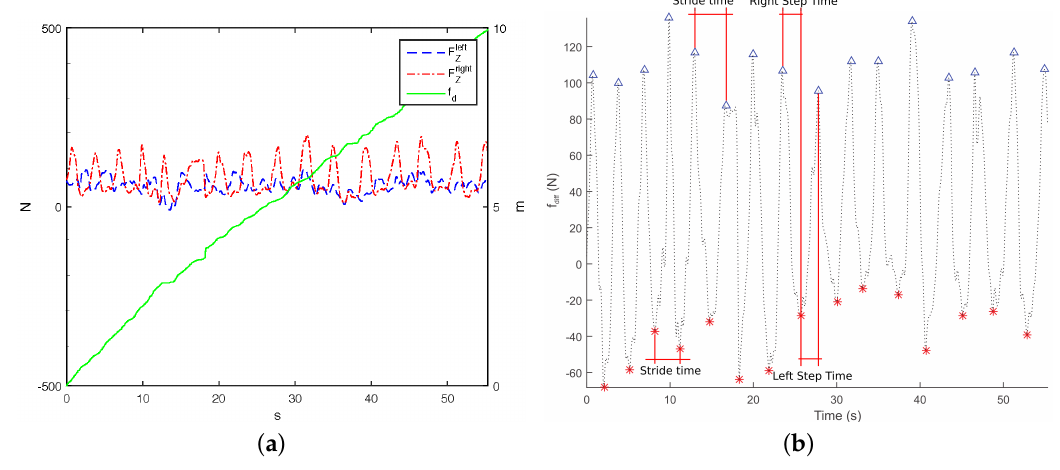
Figure 4. Spatiotemporal gait parameters on the i-Walker system in a user with polytraumatism in both lower limbs and psychological distress. ( a ) handlebar’s forces ( F left f d ; and ( b ) the inflection points in f dif f plotting over time are to be used for estimating the temporal gait